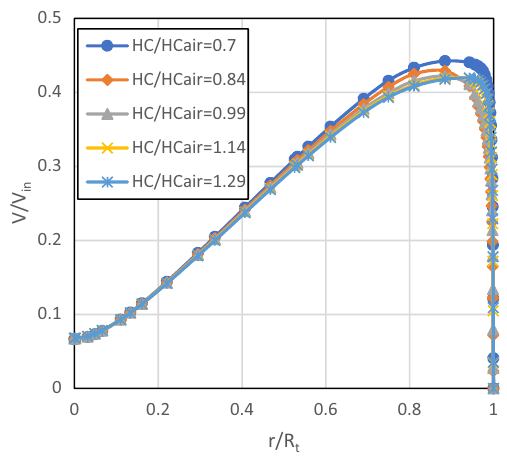
Fig. 14 Dimensionless velocity profiles versus dimensionless radial direction plotted at z ∕ L = 0.63 for various heat capacity ratios with 400 kPa at the inlet, 0 kPa at the cold outlet and 30 kPa at the hot